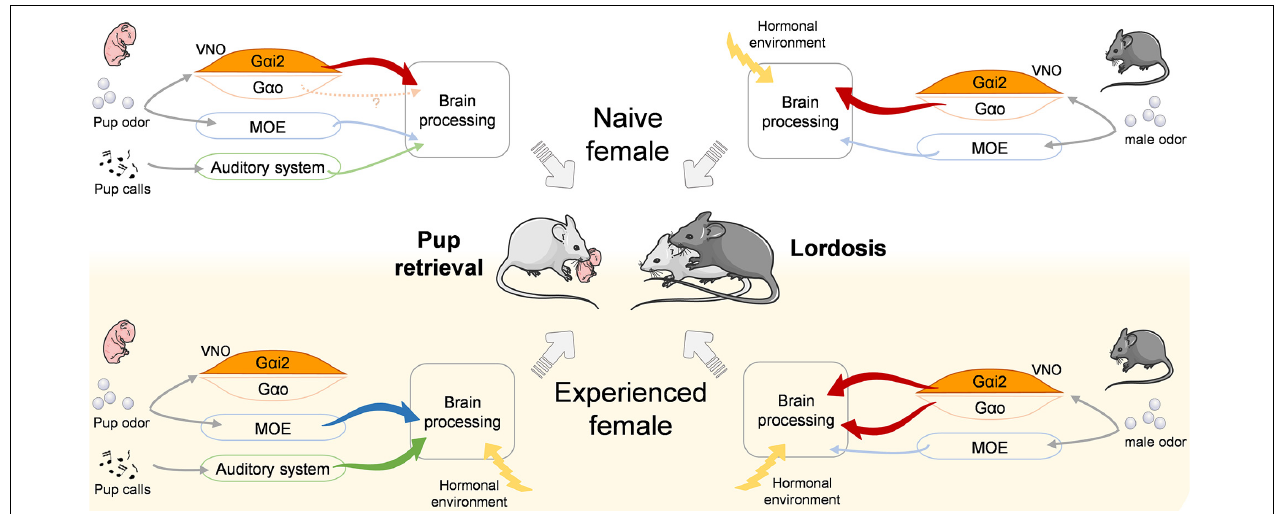
FIGURE 5 | Model for the proposed control of pup retrieval and lordosis behaviors depending on social experience. Olfactory and auditory cues relevant for pup retrieval ( left ) and lordosis ( right ) behaviors are differentially processed by the sensory systems and the brain in naïve ( top ) and experienced ( down ) females. Significantly, G α i2+ vomeronasal neurons are activated by pup odor in naïve females to trigger retrieval but are dispensable in experienced females. Inversely, they are dispensable in naïve females to trigger the lordosis response but become necessary in experienced females to reach high lordosis levels. VNO, vomeronasal organ; MOE, main olfactory